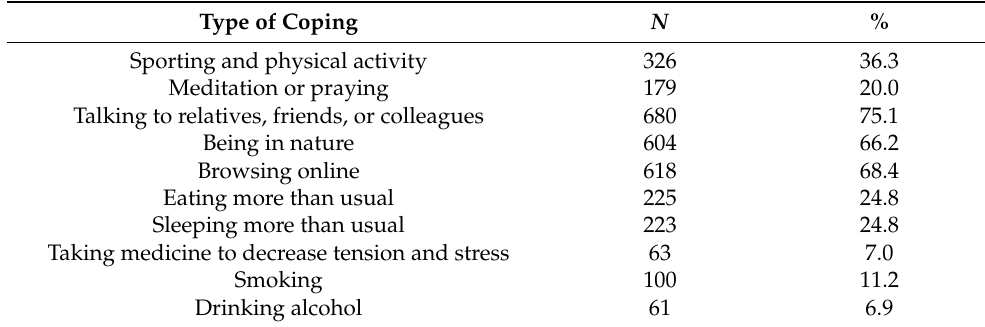
Table 3. Coping with COVID-19-related stress during lockdown (frequently or very